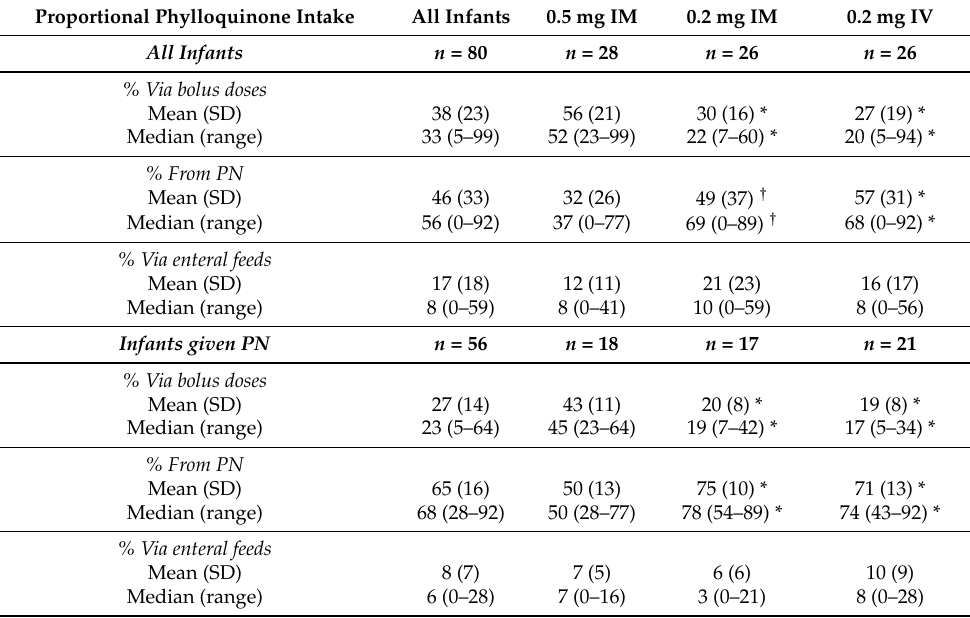
Table 6. Proportional intake of phylloquinone from each route from birth until study completion as a percentage of the total